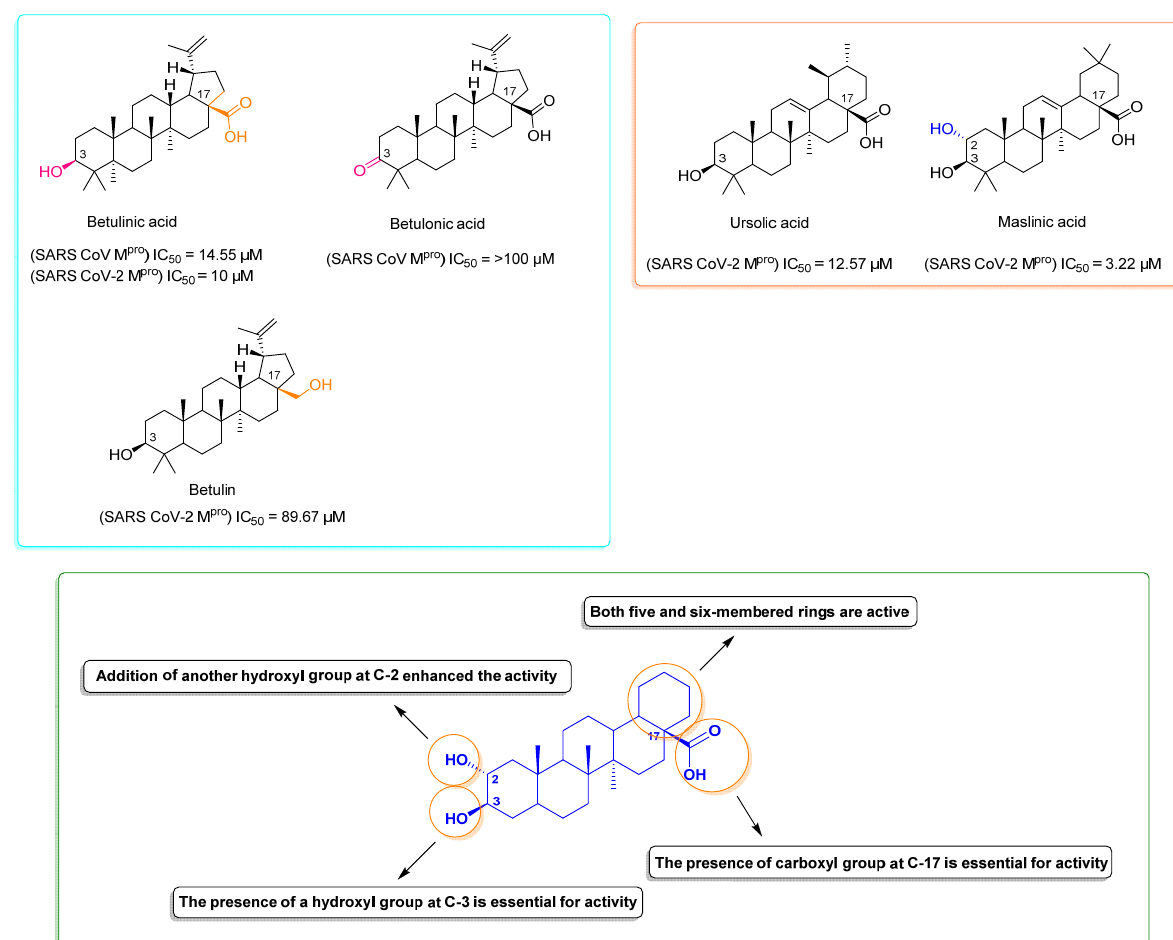
Figure 3. Structure of olive leaves-derived triterpenes investigated along with their IC 50 against SARS CoV M pro showing the main essential structural features required for the in vitro activity.